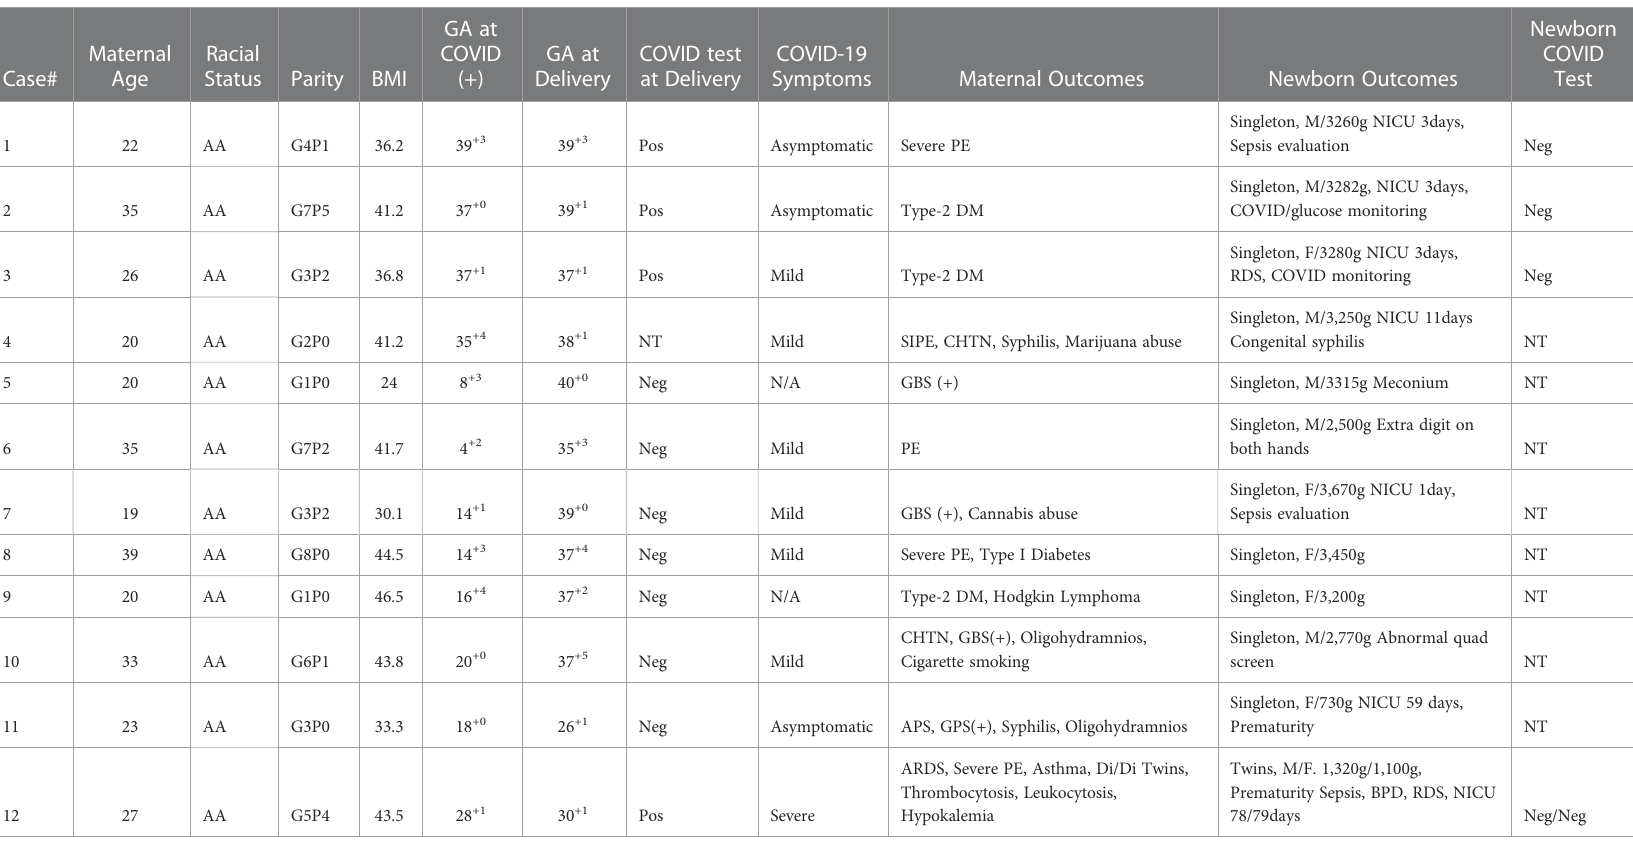
TABLE 2 Clinical characteristics of women infected with COVID-19 in